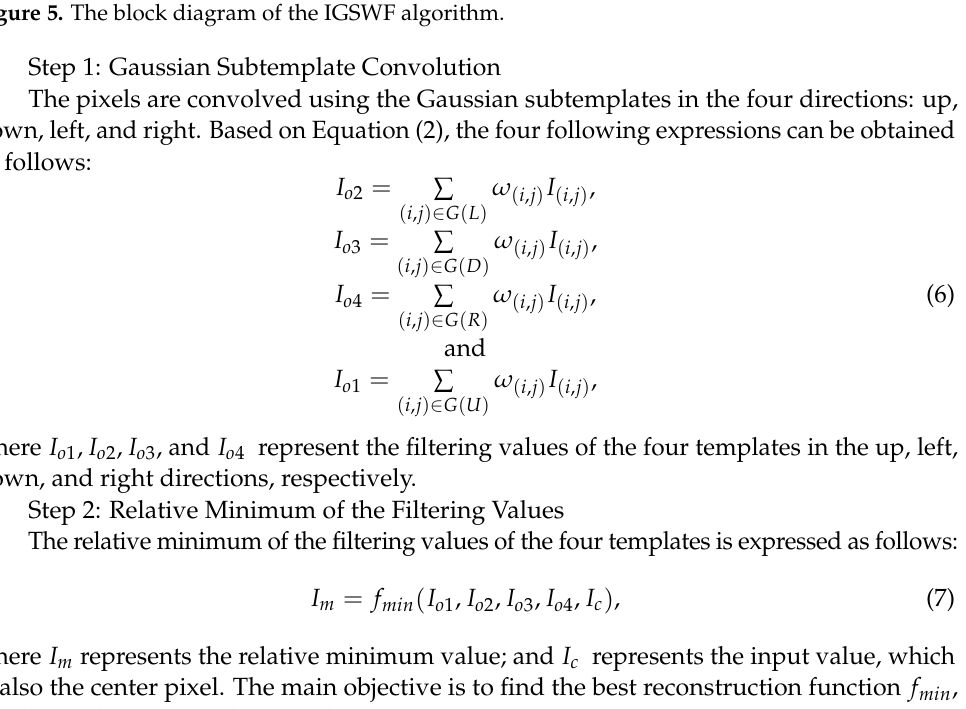
Figure 5. The block diagram of the IGSWF algorithm.